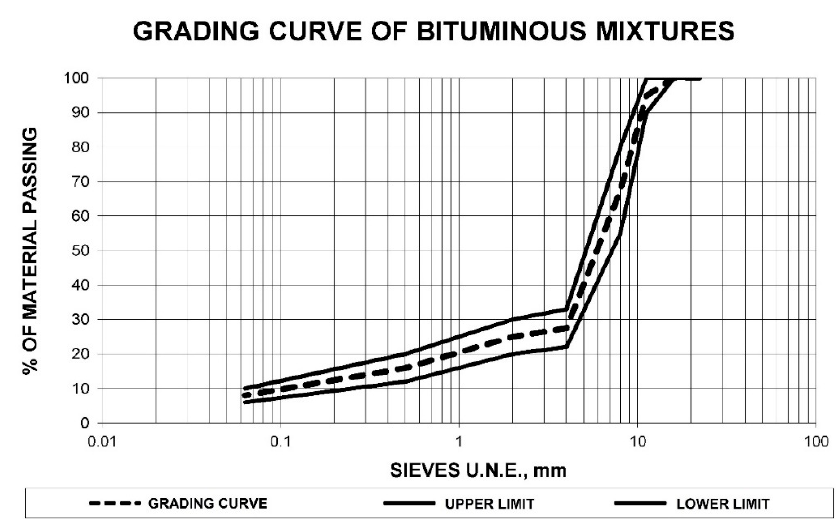
Figure 1. Grading curve of the different families of bituminous mixtures.